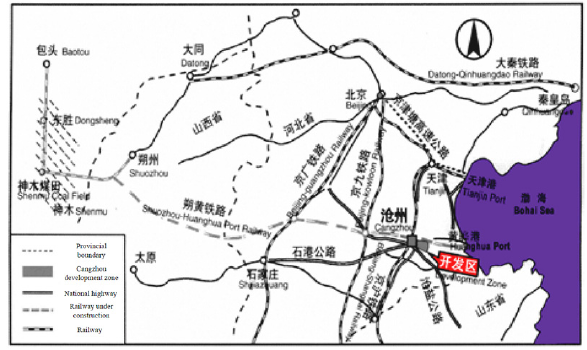
Fig. 1. Geographical location of Shuohuang